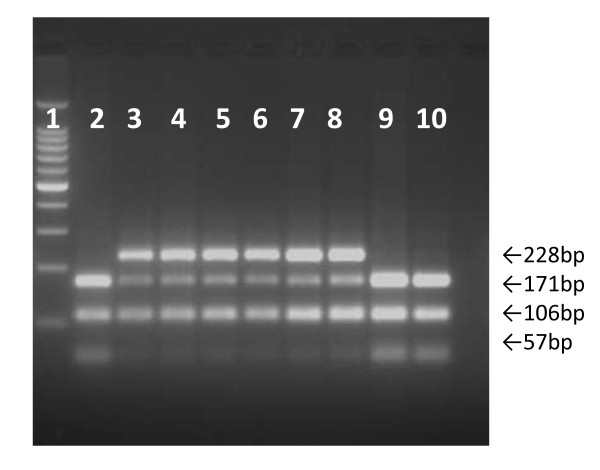
Cut DNA subsequent to digestion with MnlI. M = Molecular marker of 100 bp, lanes 1, 8, 9 = normal subjects; lane 2 and 3 = subjects heterozygous for HbE (βA/βE); lanes 4-7 = subjects compound heterozygous for HbE and beta thalassaemia; lane 10 = blank.